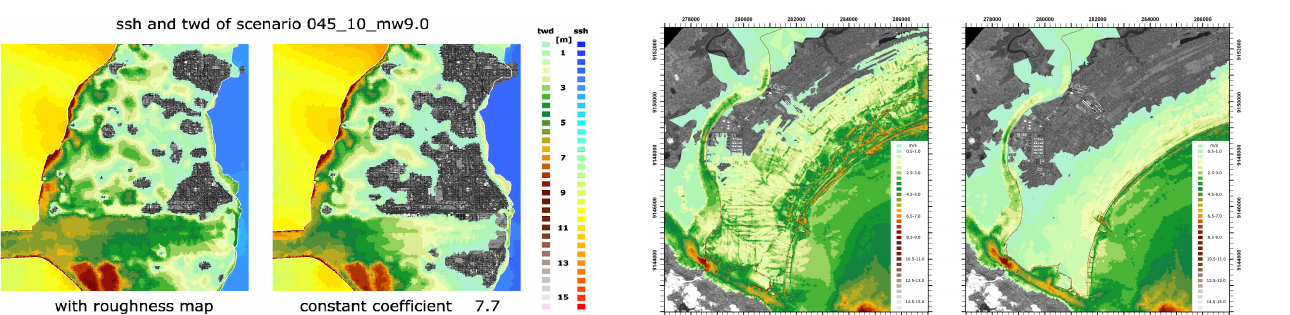
Fig. 10. Cilacap, Java. Maximum flow velocities for a scenario of earthquake magnitude 9 (065 12 mw9.0). Left: with detailed roughness map, right: with constant Manning value M =7.7m 1 / 3 /s everywhere.